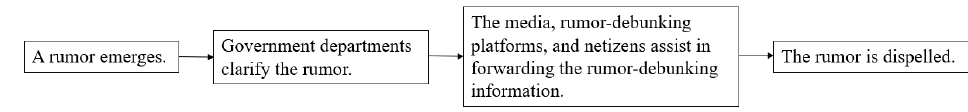
Figure 1. The “ government- led” rumor -debunking model. Figure 1. The “government-led” rumor-debunking